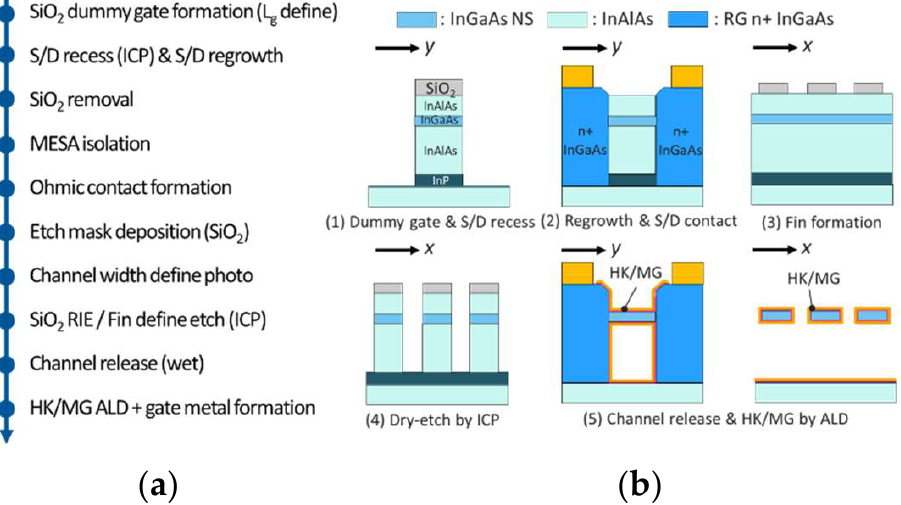
Figure 2. ( a ) Process flow and ( b ) key unit process steps of the GAA In 0.53 Ga 0.47 As NS MOSFETs that are in this work.